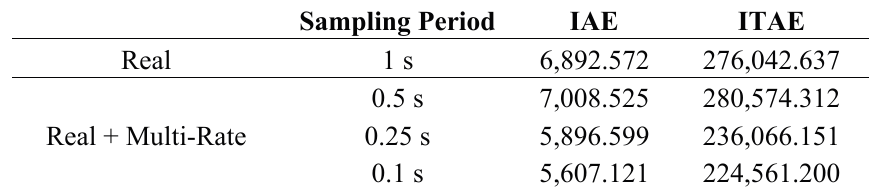
Table 1. Performance indexes of the WNCS for real sampling of 1 s and soft sensor and multi-rate of 0.5, 0.25 and 0.1